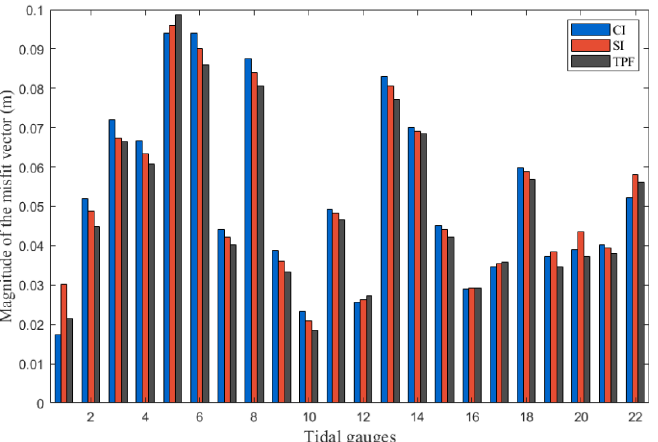
Figure 13. Magnitude of the misfit vector between the simulations and each tidal gauge.